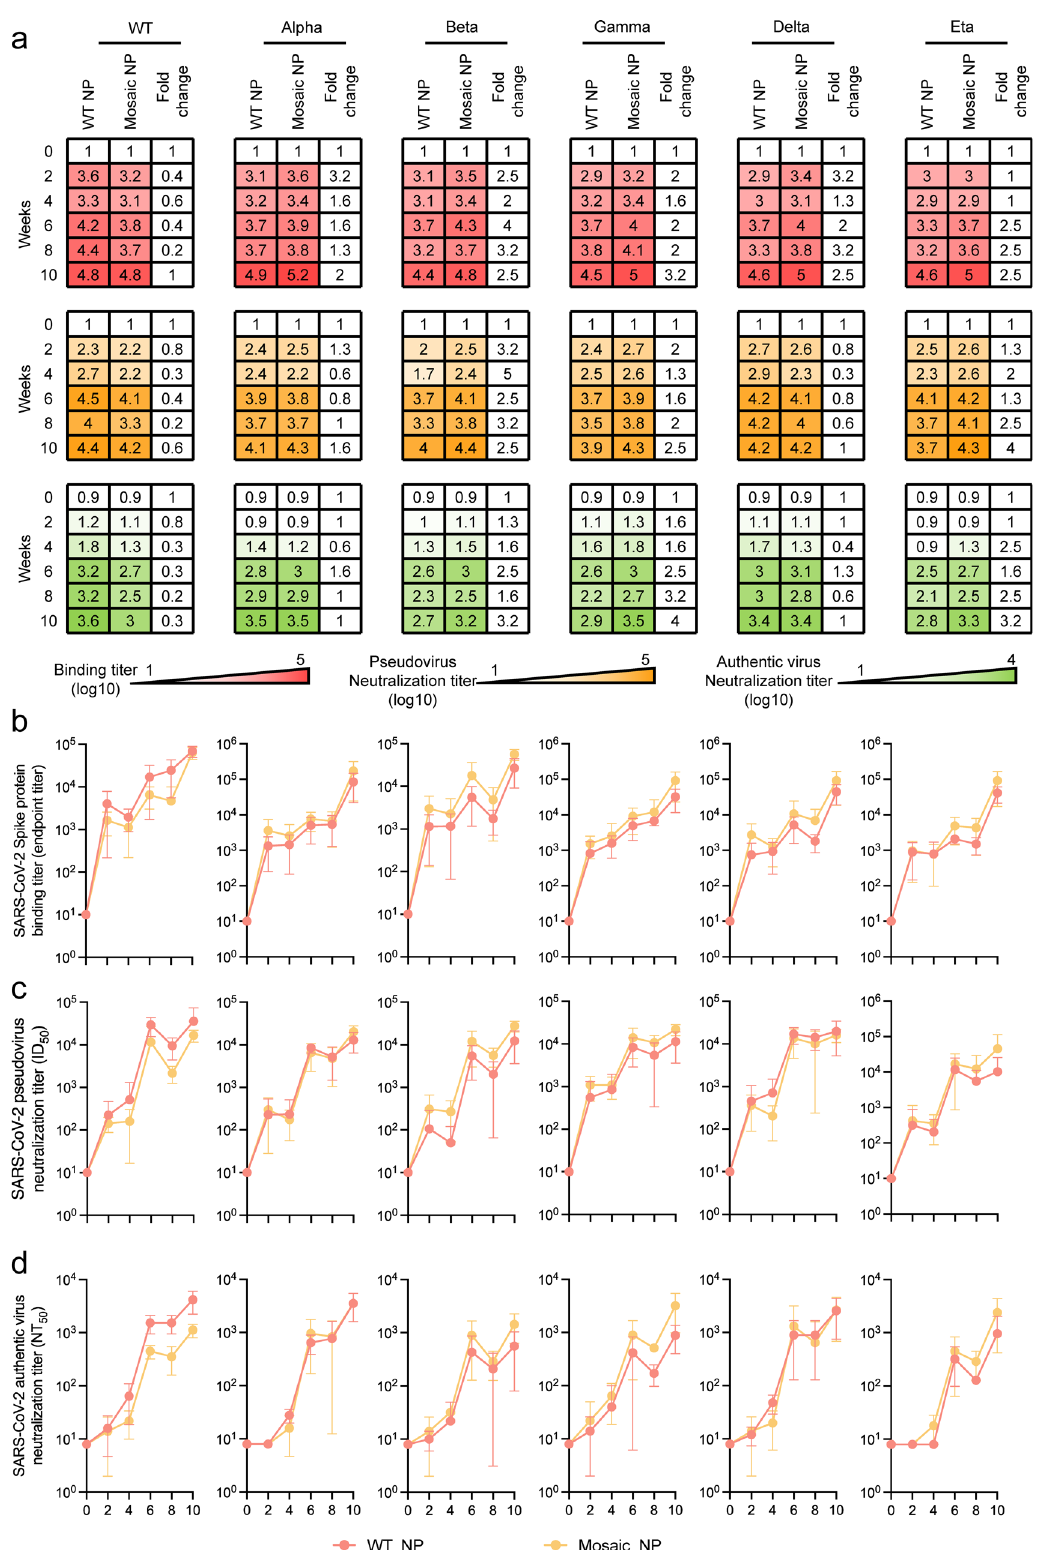
vaccine, we performed competitive BLI analysis with hACE2, which binds to the receptor-binding domain of spike protein. At a 1000-fold dilution, serum from cynomolgus macaques vaccinated with Mosaic NP adjuvanted with MF59 was more competitive than the ACE2 receptor for binding to wild-type, Alpha, Beta, and Gamma variants but not for HexaPro trimer of Delta and